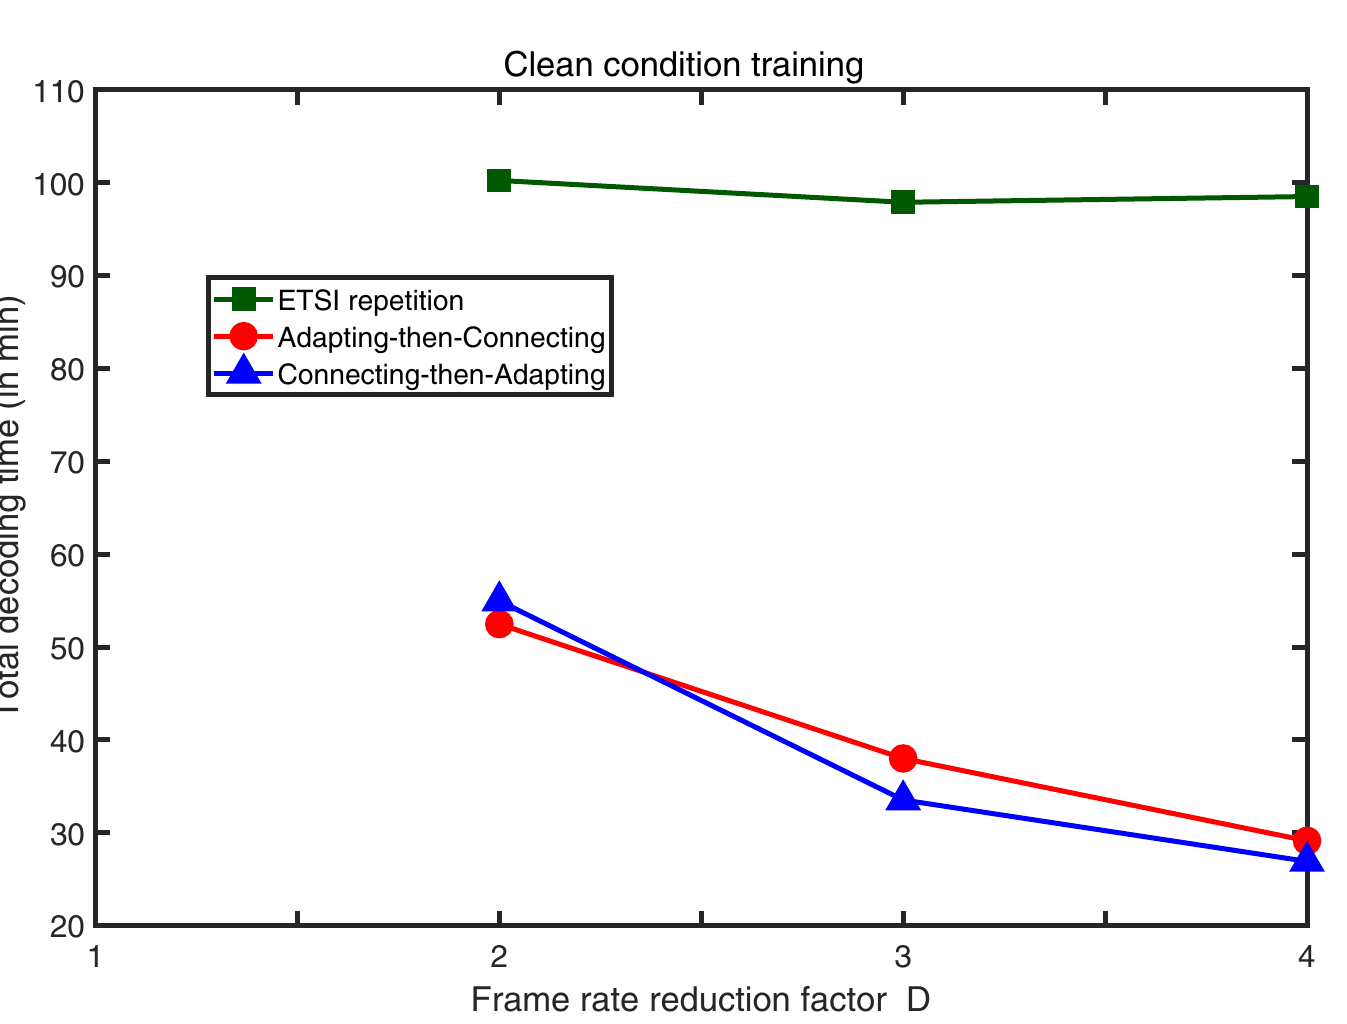
Fig 13. The total decoding time of all three test data sets of AURORA 2 with clean condition training for the ETSI repetition and the two adaptation approaches.